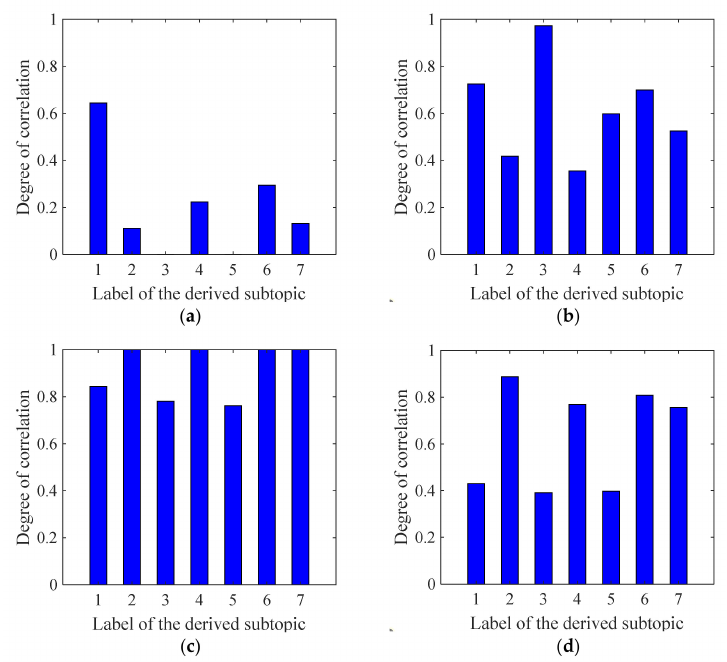
Figure 19. The correlation between derived subtopic number and initial public